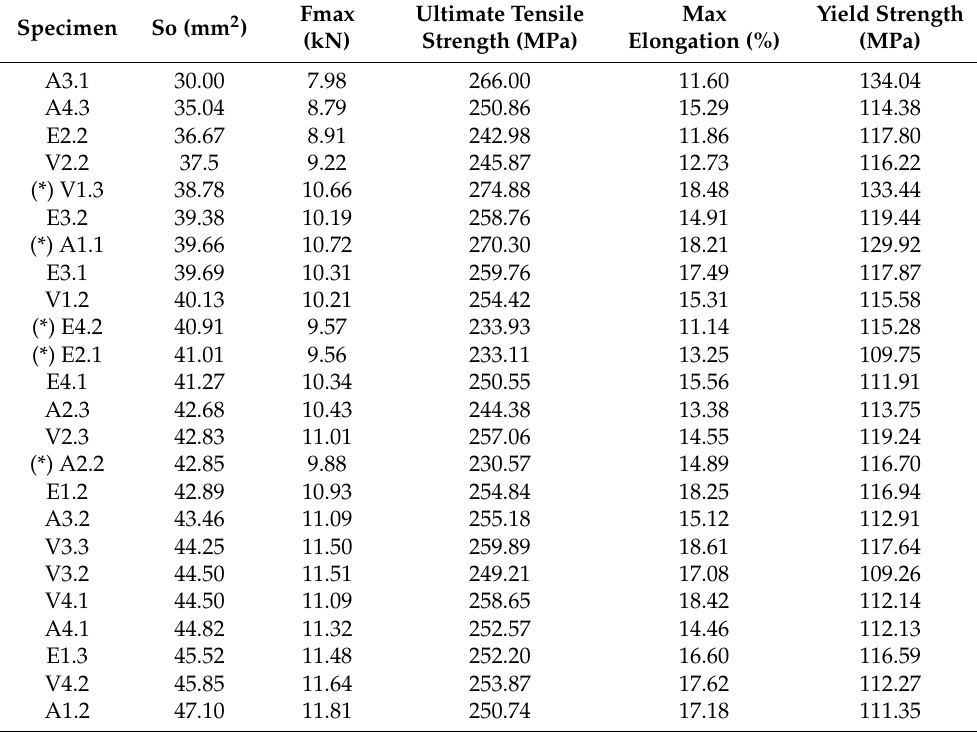
Table 6. Tensile testing results, ordered by section (mm 2